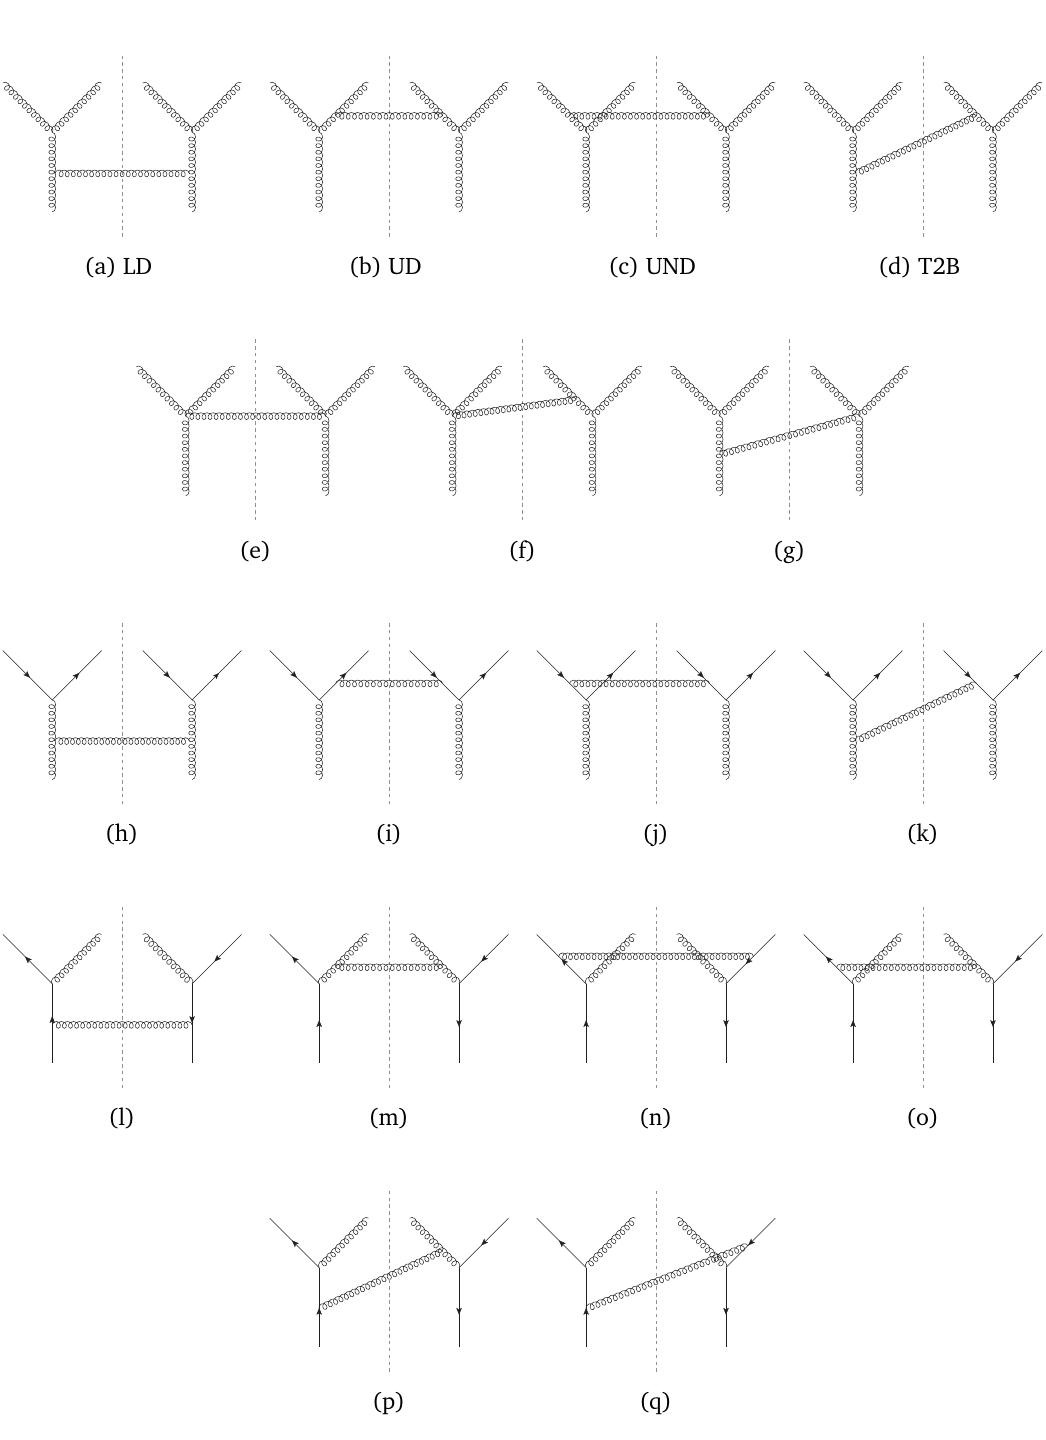
Figure 1: Real graphs for LO channels. The parton lines at the bottom of the graph correspond to a , and those on top to a 0 topologies “LD”, “UD” etc. are explained in section